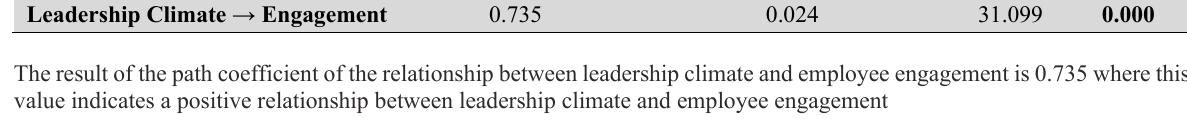
Path Coefficient & T Statistic Leadership Climate →